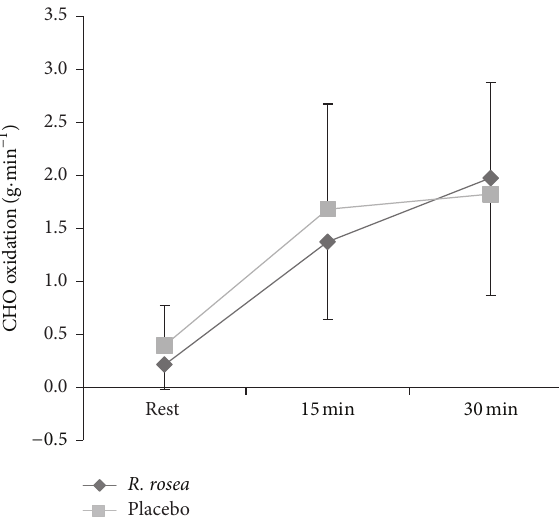
Figure 4: Mean ± S.D. total CHO oxidation rate (g ⋅ min −1 ) during 30 min submaximal cycling between R. rosea and placebo condi- tions.